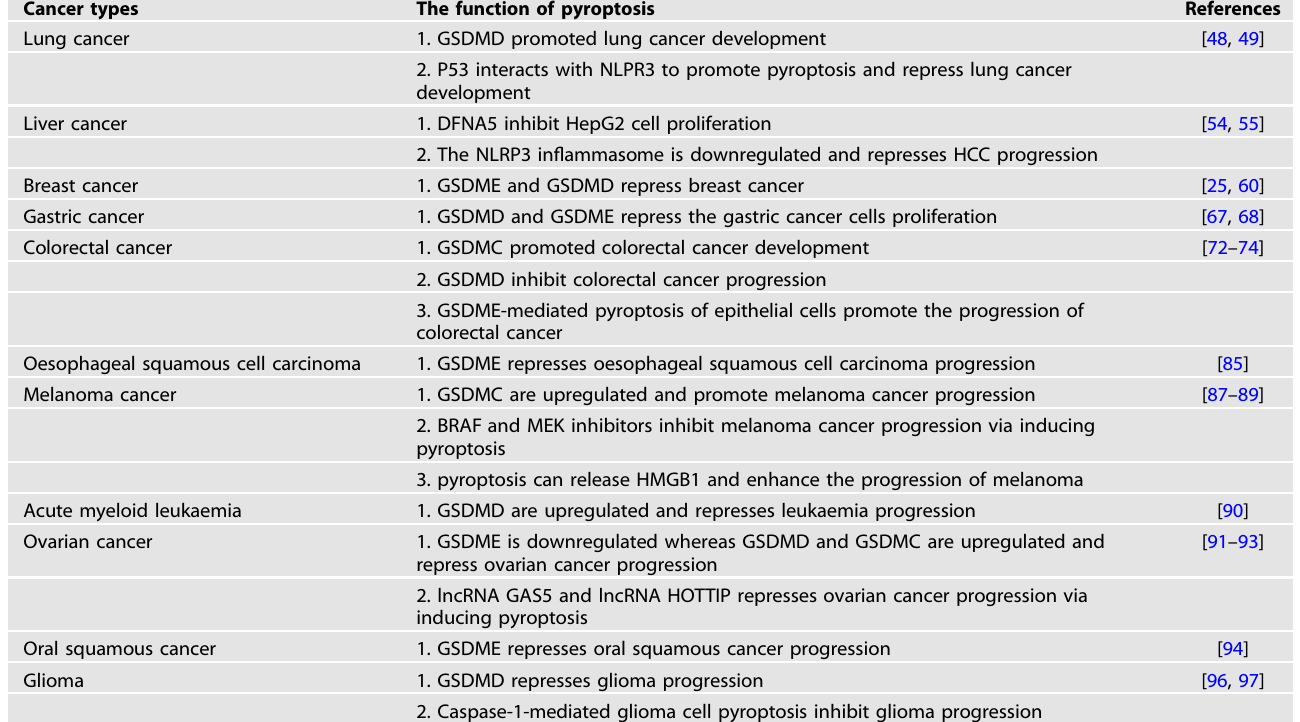
Table 2. The role of pyroptosis in